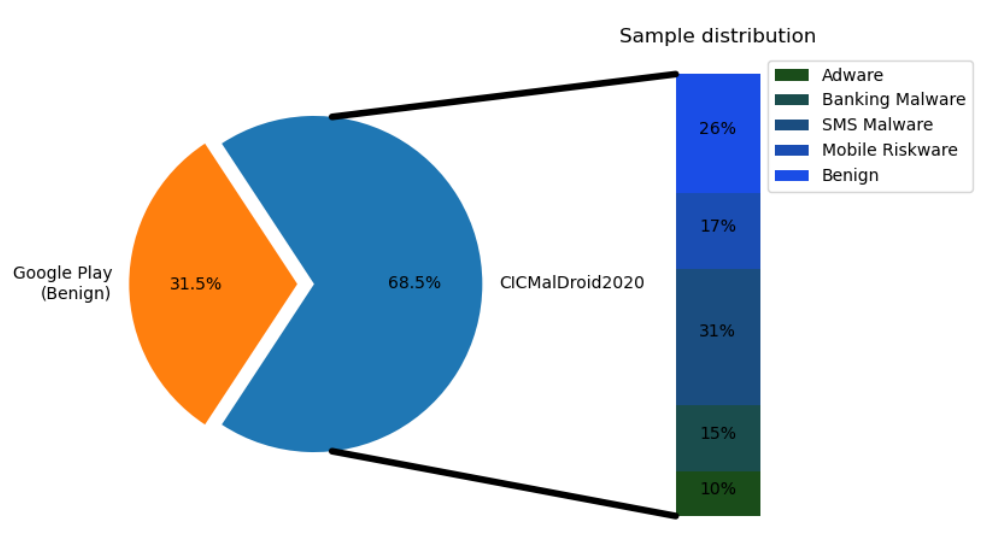
Figure 8. Dataset